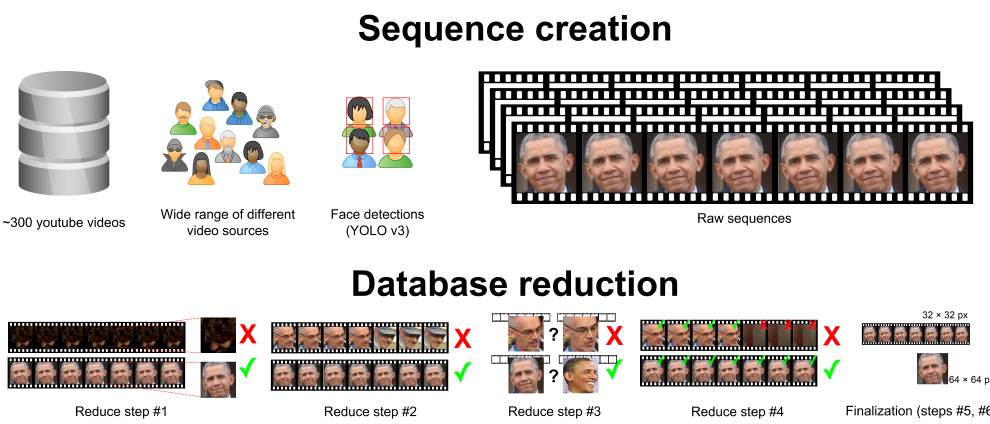
Figure 5. Scheme of the process, how the dataset was created. #1 The middle (label) image has to be recognized by Face-recognition, #2 All images in the sequence have to contain the same person, #3 Removed duplicate person records. Same persons with different conditions (light, angle, ...) remain, #4 Every image in the sequence has to contain a face, #5 Sequence and label resizing, interpolation and quality selection, #6 Final validation whether the resulting label can be still recognized by the Face-recognition